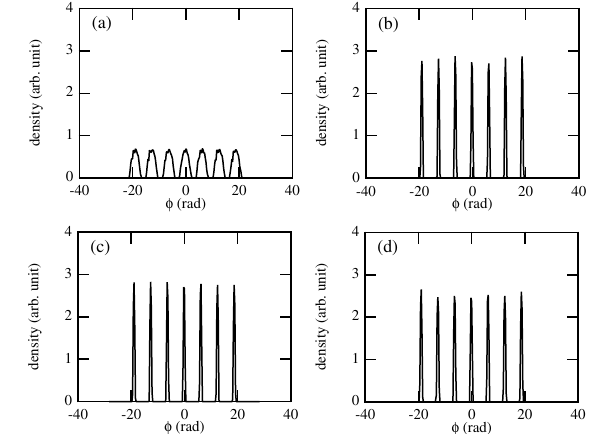
FIG. 11. Blowup factor of the emittance in the dependence (rad) where k is set to (cid:5) 0 : 43 (cid:1) kV =(cid:22) s (cid:2) , and on (a) (cid:23) 0 is set to 7 (cid:14) (rad). Emittance growth (b) k (cid:1) kV =(cid:22) s (cid:2) where (cid:23) 0 become larger. becomes larger as k and (cid:23) 0